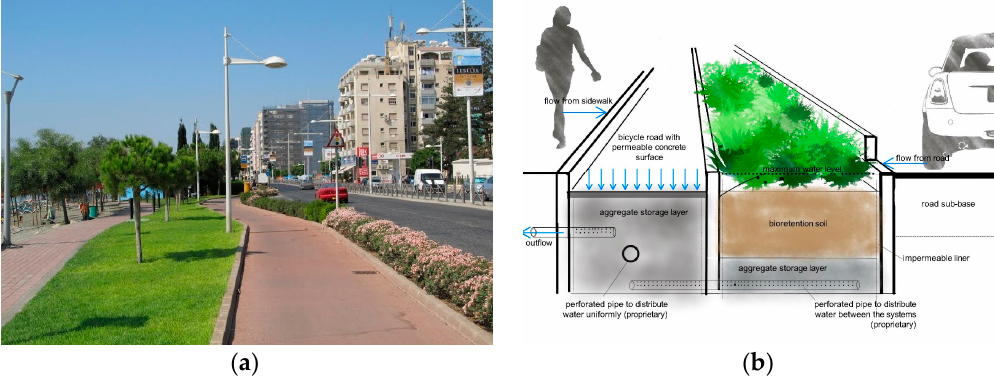
Figure 5. ( a ) The coastal road of Limassol; ( b ) Graphical representation of a combined system with a bioretention planter and a permeable pavement to store or retain water that could be